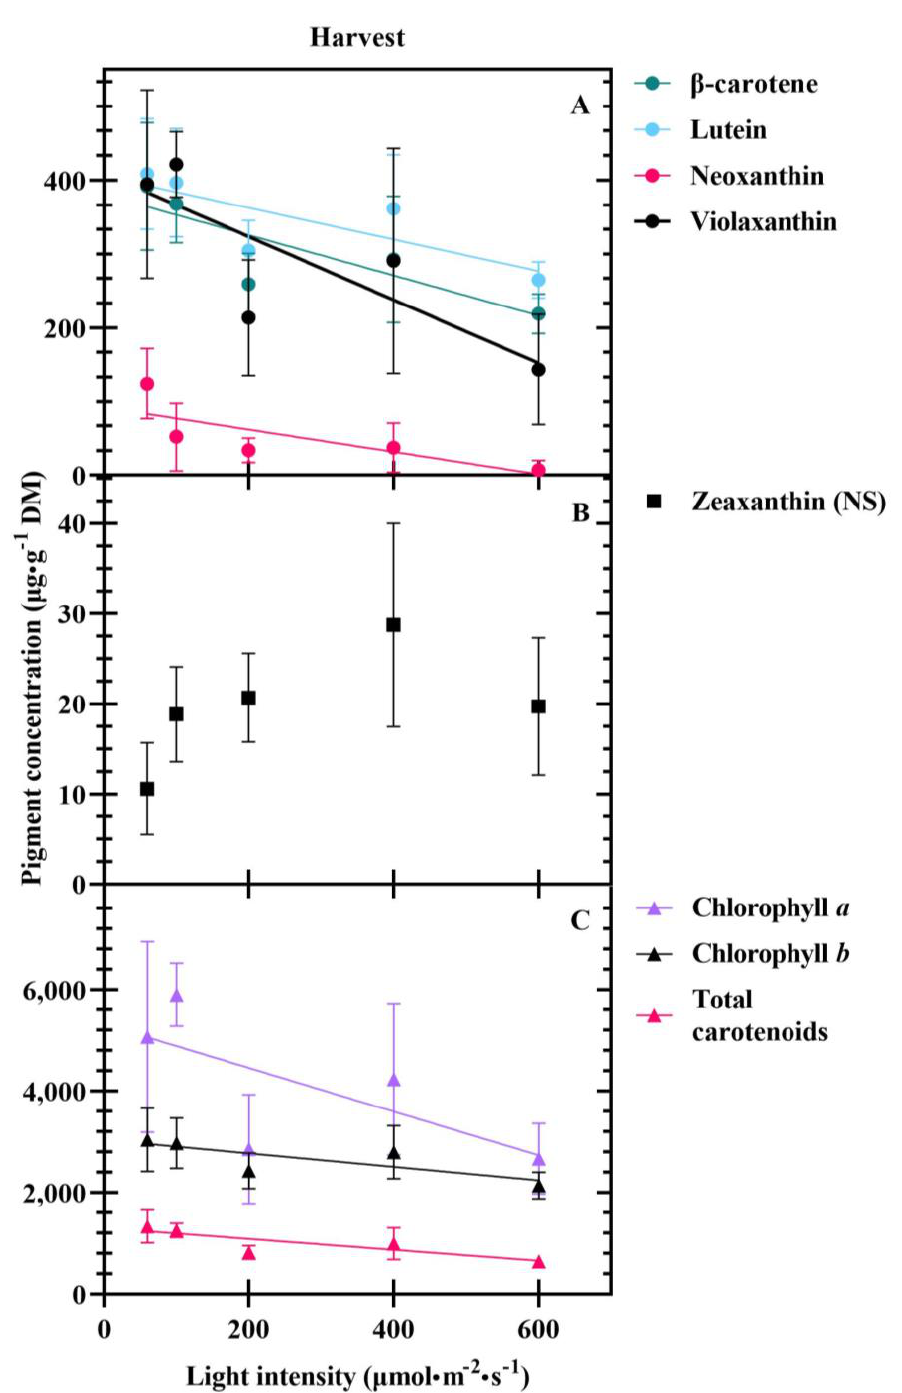
Figure 5. Concentrations [µg·g − 1 dry mass (DM)] of β -carotene, lutein, neoxanthin, and violaxanthin ( A ), zeaxanthin ( B ), chlorophyll a and b , and total carotenoids ( C ) of butterhead lettuce ‘Rex’ ( Lactuca sativa ) seedlings grown under light intensities of 60, 100, 200, 400, or 600 µ mol · m − 2 · s − 1 for a 24-h photoperiod for 14 d and then transplanted into a common greenhouse environment and grown for 21 d. Each symbol represents the mean of 12 plants ± SE. Lines represent linear, quadratic, or quadratic plateau regression. Equations and significance are reported in Table 4.